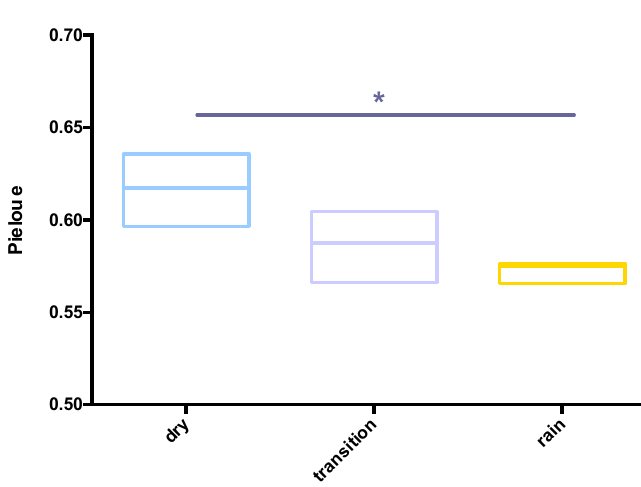
Figure A4. The Pielou number for bacterial equitability in the Cerrado soil (60 cm depth), mound surface (0 cm), and mound soil (60 cm depth) samples collected for the dry, transition, and rainy season in 2017 and 2018. Statistically significant values ( p < 0.05) are indicated with ‘*’.